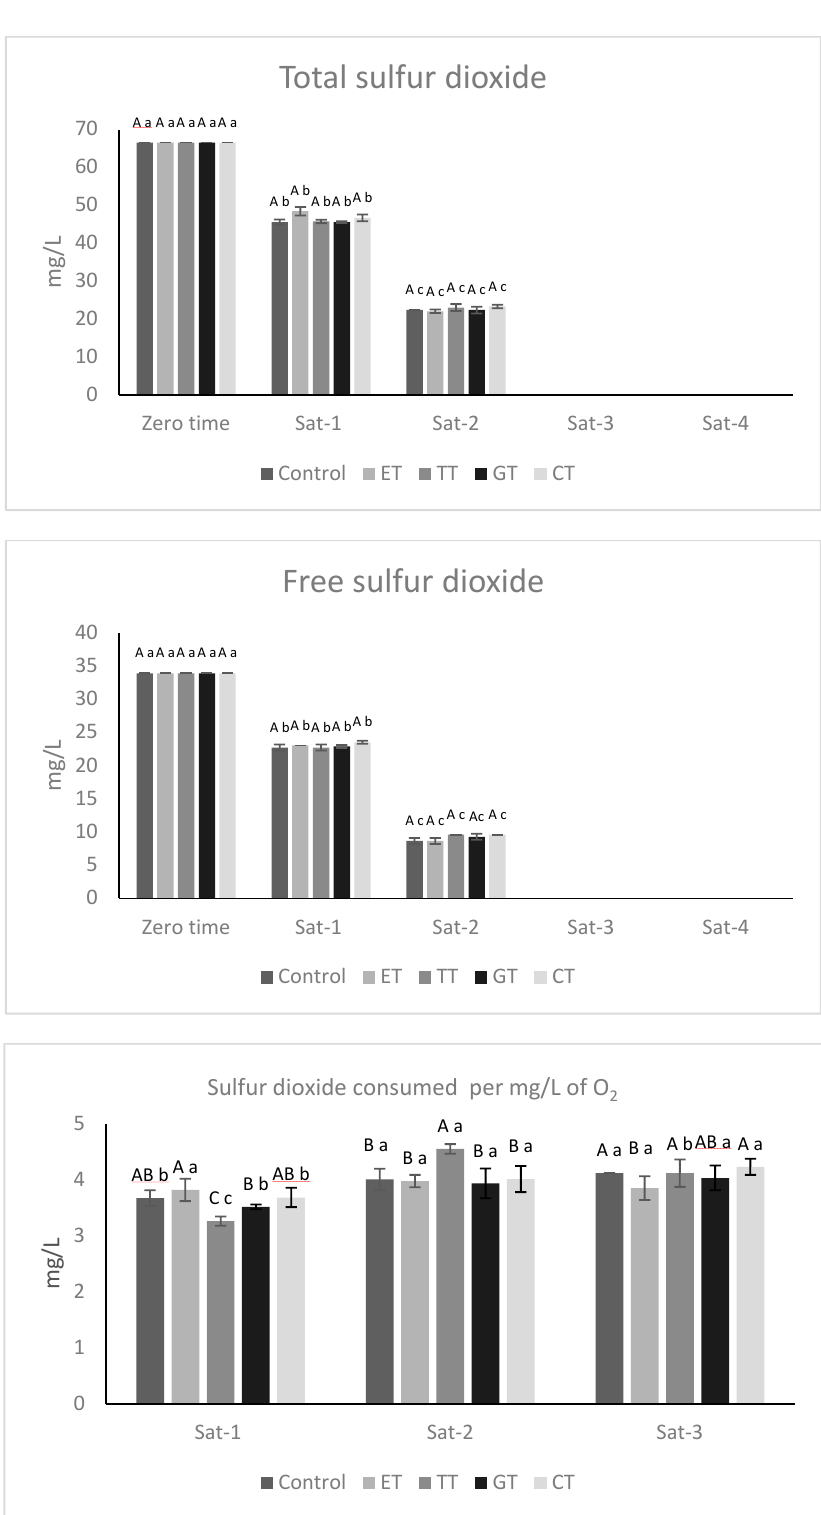
Figure 3. ( A ) Evolution of free sulfur dioxide and ( B ) evolution of total sulfur dioxide. ( C ) Sulfur dioxide consumed per mg / L of oxygen. All the data are expressed as means ± standard deviation. Di ff erent letters indicate a statistically significant di ff erence among treated wines during each saturation time (A, B, C, D) and among treated wines for the same saturation time (a, b, c, d). All the data are expressed as means ± standard deviation, ( p < 0.05).